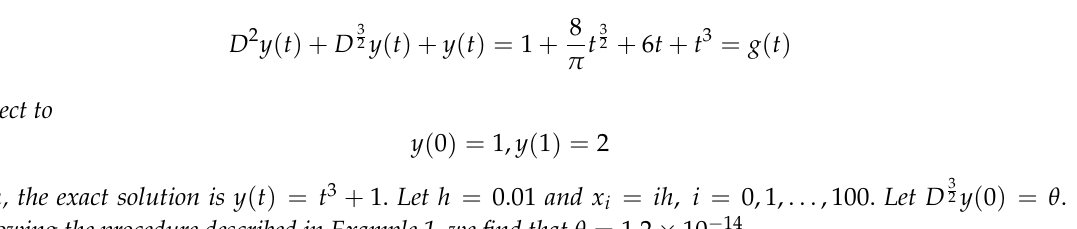
Figure 2 The exact and the approximate solutions for Example 1 when 𝛼 = 0 . Figure 2. The exact and the approximate solutions for Example 1 when α